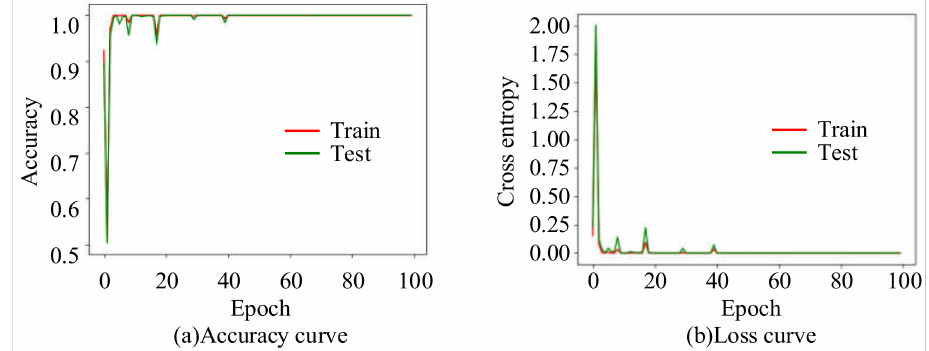
Figure 8. Experimental result of bearing dataset. ( a ) Accuracy curve. ( b ) Loss